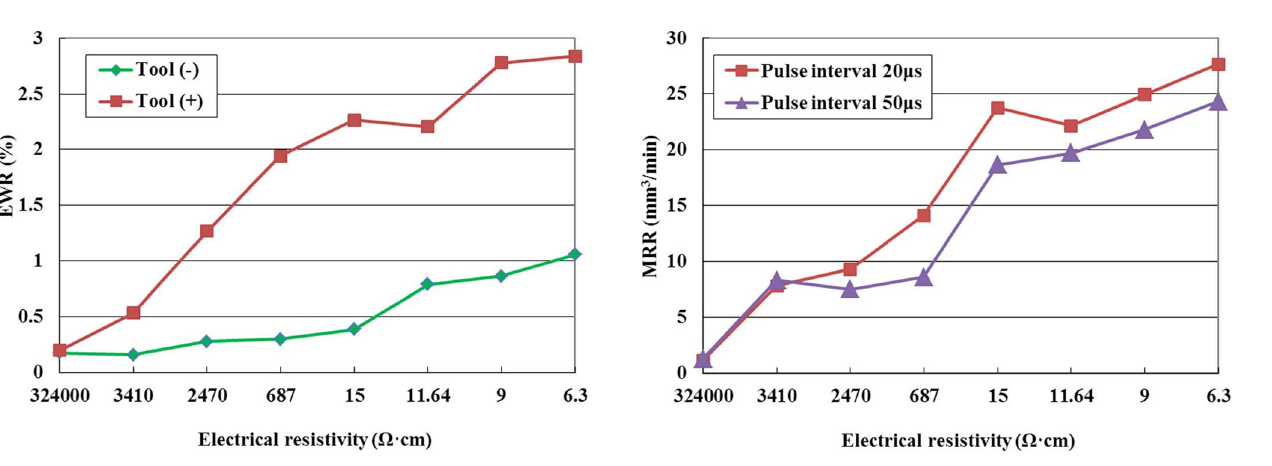
Figure 8. Effect of the pulse interval on MRR.